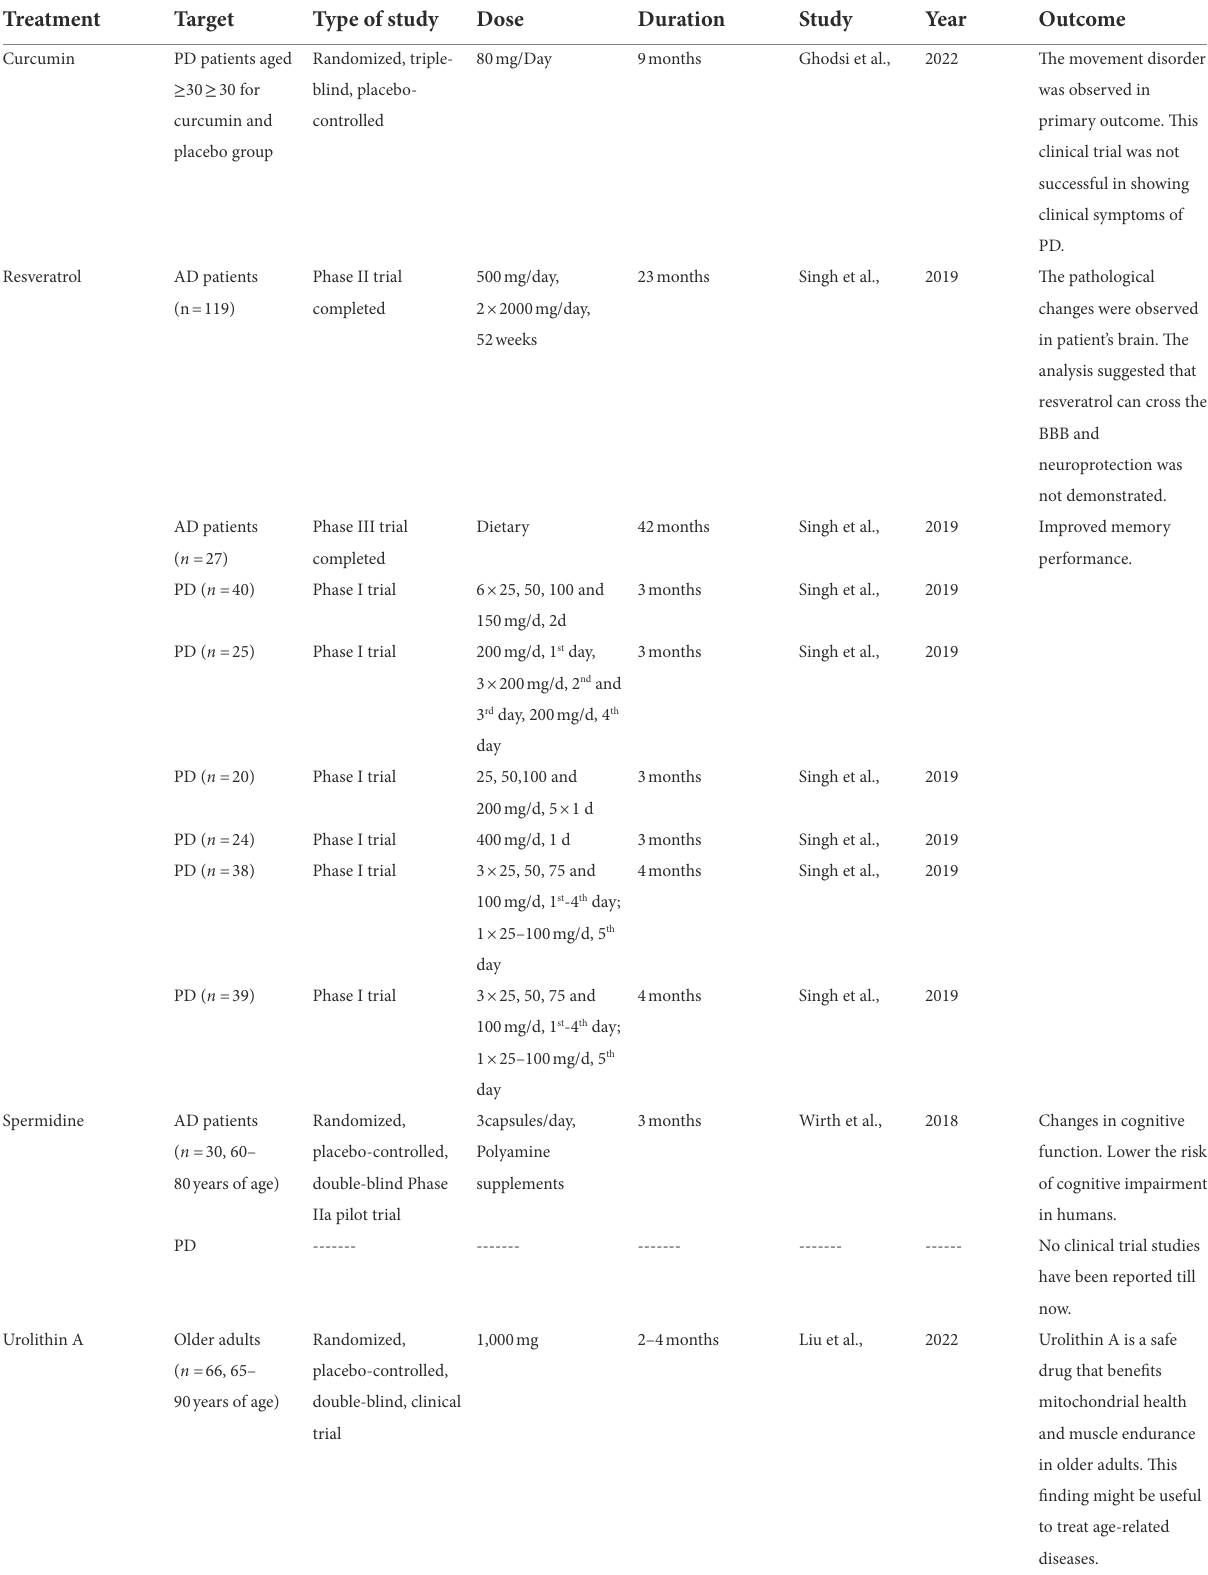
TABLE 3 Summary of clinical trials in Parkinson’s disease using mitophagy